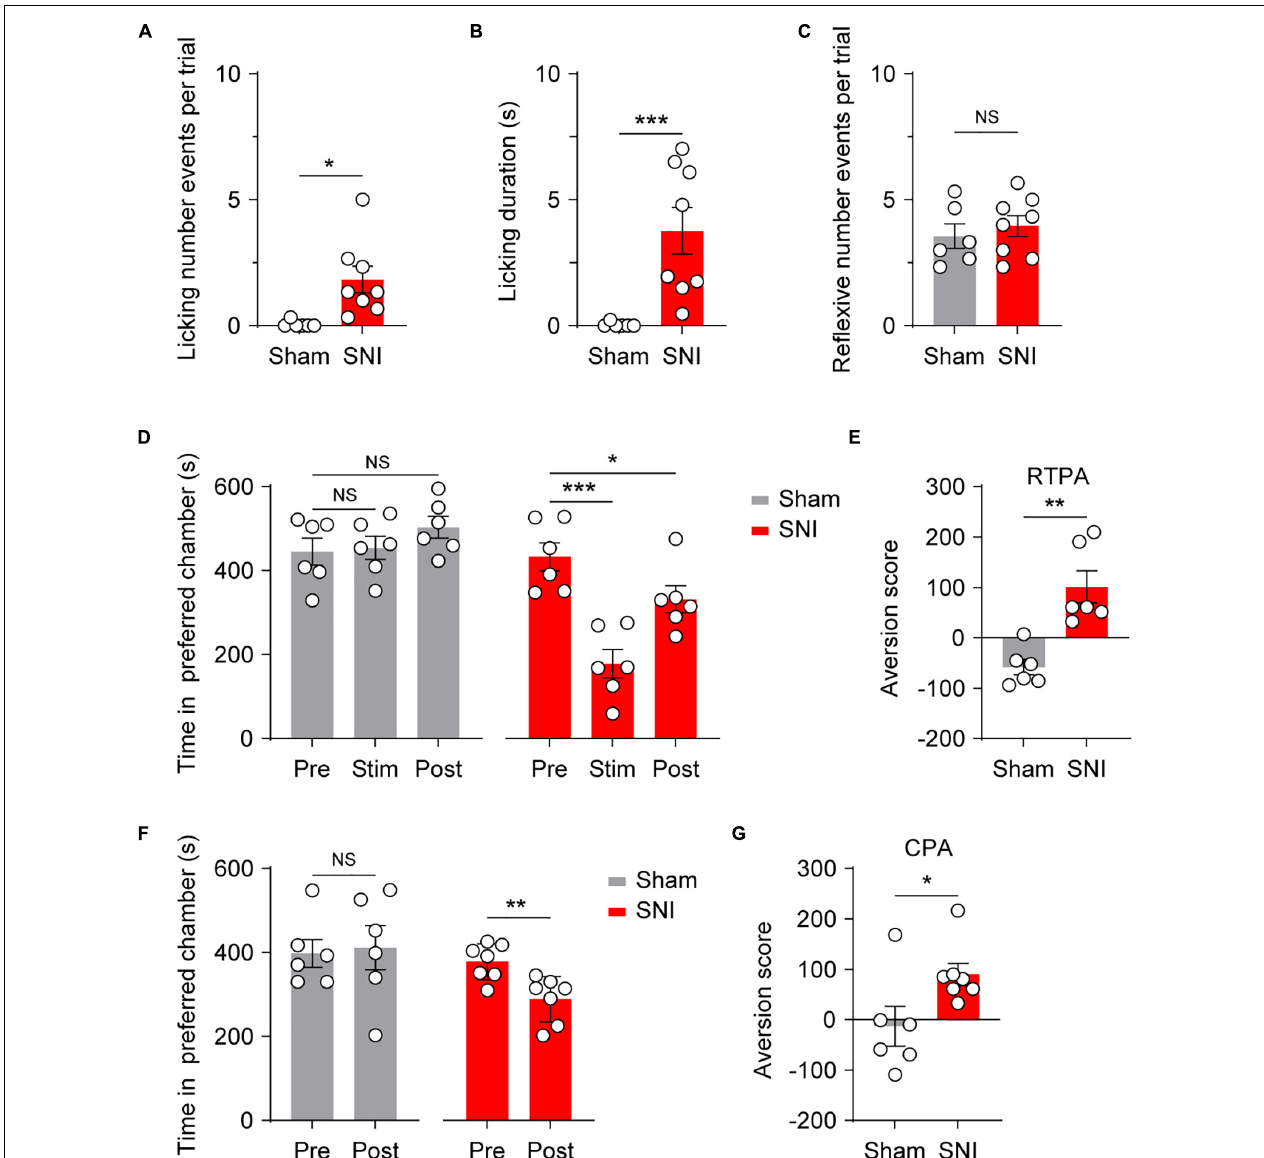
FIGURE 4 | Optogenetic activation of cutaneous Mrgprd + fibers induces affective behaviors and aversion under neuropathic pain conditions. (A,B) Statistical data for episodes of licking behaviors (A) and licking durations (B) evoked by optogenetic activation of Mrgprd + fibers in sham Mrgprd-ChR2 mice ( n = 6 animals) and SNI Mrgprd-ChR2 mice ( n = 8 animals). (C) Statistical data for reflexive behaviors evoked by optogenetic activation of Mrgprd + fibers in sham Mrgprd-ChR2 mice ( n = 6 animals) and SNI Mrgprd-ChR2 mice ( n = 8 animals). (D–E) Time spent in preferred chamber and aversion score for RTPA in sham/SNI Mrgprd-ChR2 mice ( n = 6 animals per group). (F,G) Time spent in preferred chamber and aversion score for CPA in sham/SNI Mrgprd-ChR2 mice (sham, n = 6 animals, SNI, n = 7 animals). Data are presented as mean ± SEM. “NS,” no significance, * p < 0.05, ** p < 0.01, *** p < 0.001. Mann–Whitney U Test for (A,B,E,G) ; unpaired Student’s two-tailed t -test for (C) ; One-way repeated-measures ANOVA with holm-sidak test for (D) ; paired Student’s two-tailed t -test for (F)